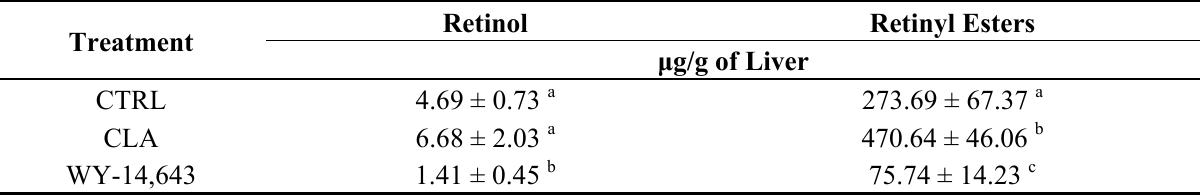
Table 1. Retinol and retinyl esters concentration in liver of female mice fed for 42 weeks control diet (CTRL), or CTRL diet + 1.5% of conjugated linoleic acid (CLA) (mixture 1:1 of c9, t11 and t10, c12), or CTRL diet + 0.01% of